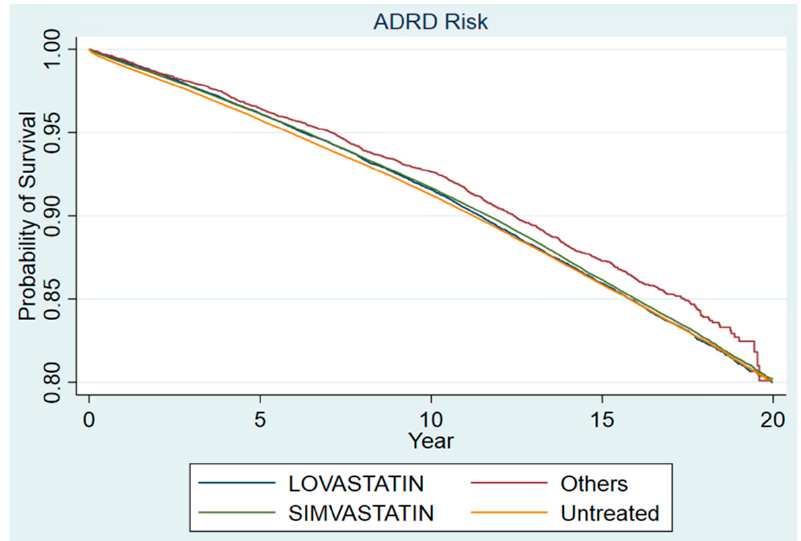
Figure 3. Kaplan-Meier survival estimates for statin and non-statin initiators .